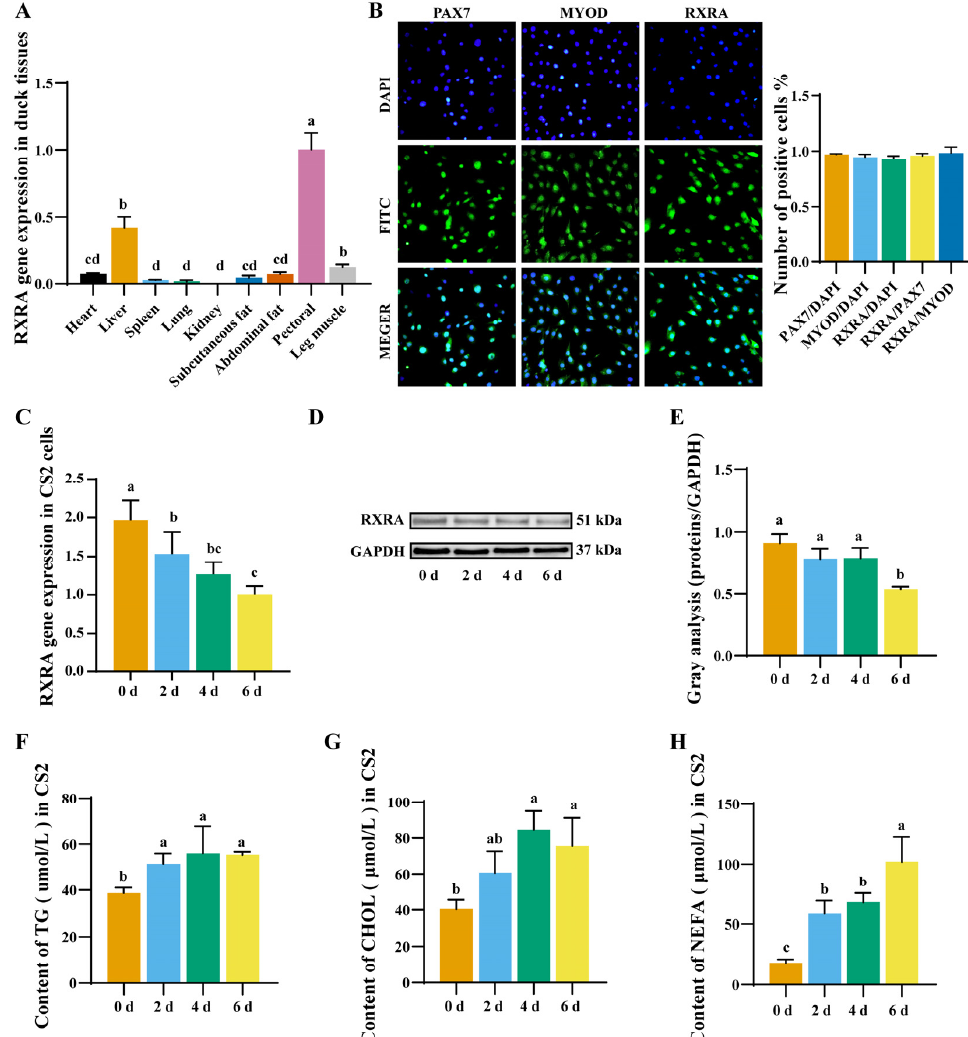
Figure 1. Expression level of RXRA gene in duck tissue and myoblasts differentiation. ( A ) The expression level of the RXRA gene in duck tissues. ( B ) Immunostaining with anti-PAX7, anti-MYOD, and anti-RXRA antibodies, and the ratio of positive cells. The images were taken under 20×. ( C ) The expression of RXRA gene mRNA in myoblasts at 0 days, 2 days, 4 days, and 6 days of differentiation. ( D ) The expression of RXRA protein in myoblasts at 0 days, 2 days, 4 days, and 6 days of differentiation. ( E ) The relative fold change in RXRA/GAPDH as determined by western blotting was quantified through a gray scale scan. The contents of TGs ( F ), CHOL ( G ), and NEFAs ( H ) in myoblasts at 0 days, 2 days, 4 days, and 6 days of differentiation. a–d different superscripts mean a significant difference ( p < 0.05).